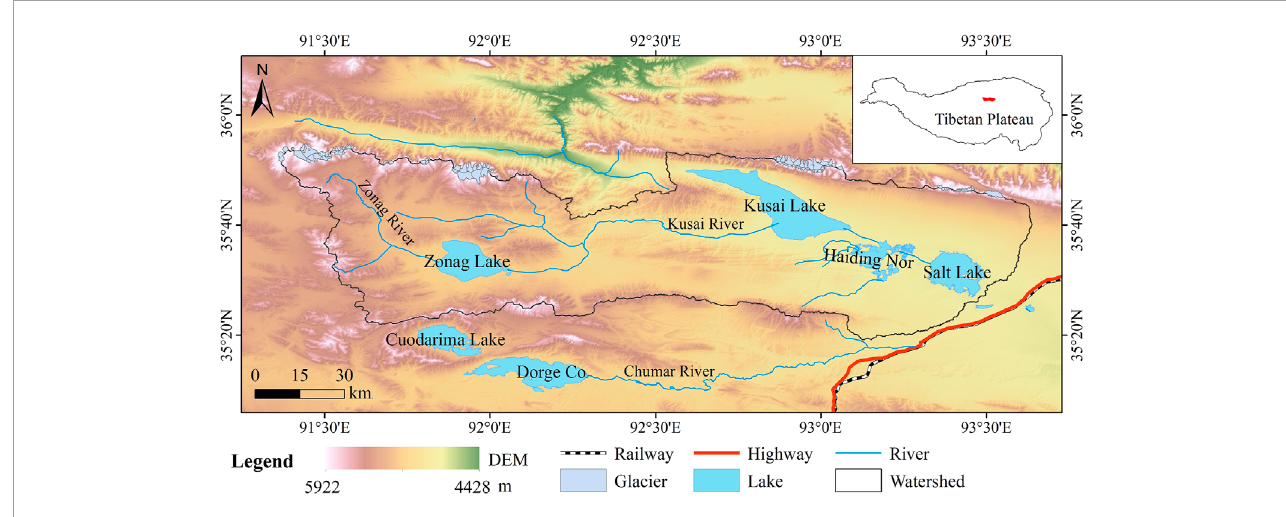
FIGURE 1 The spatial distribution of the Zonag Lake and the Salt Lake drainage